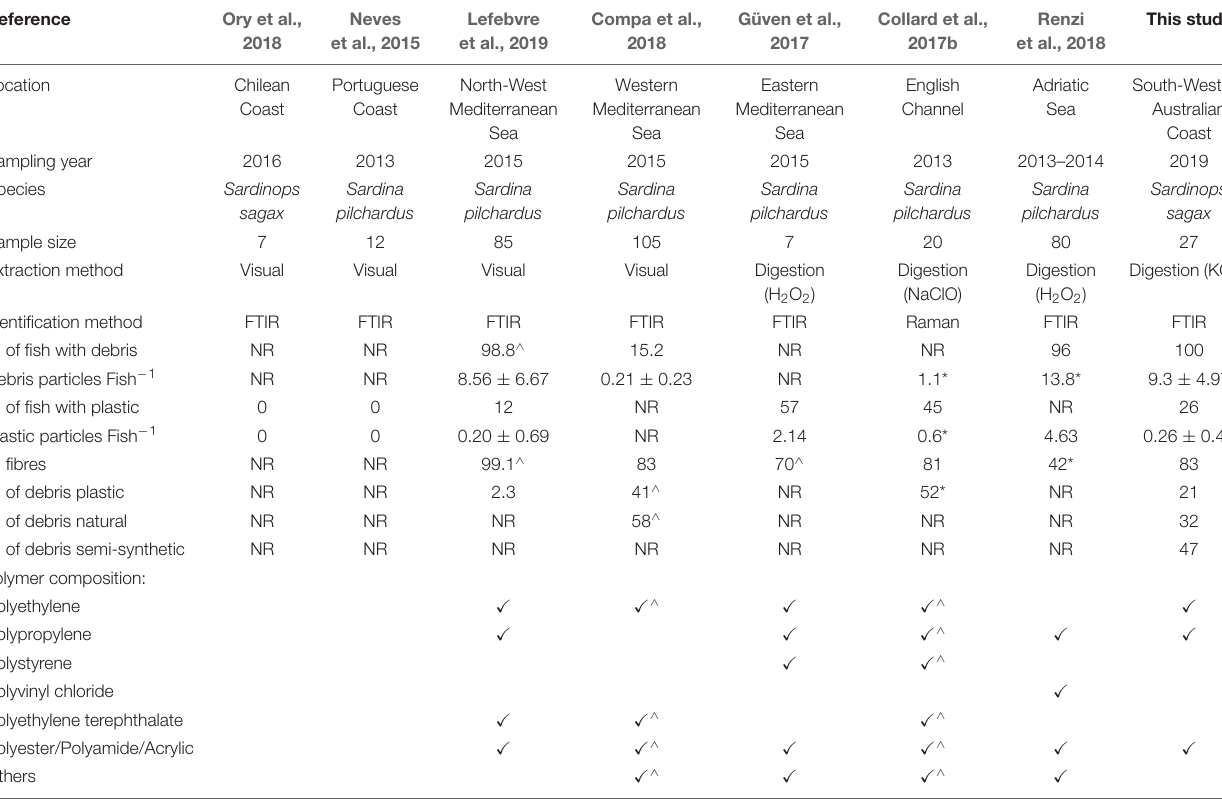
TABLE 1 | Global summary of marine debris ingestion studies using sardine species.